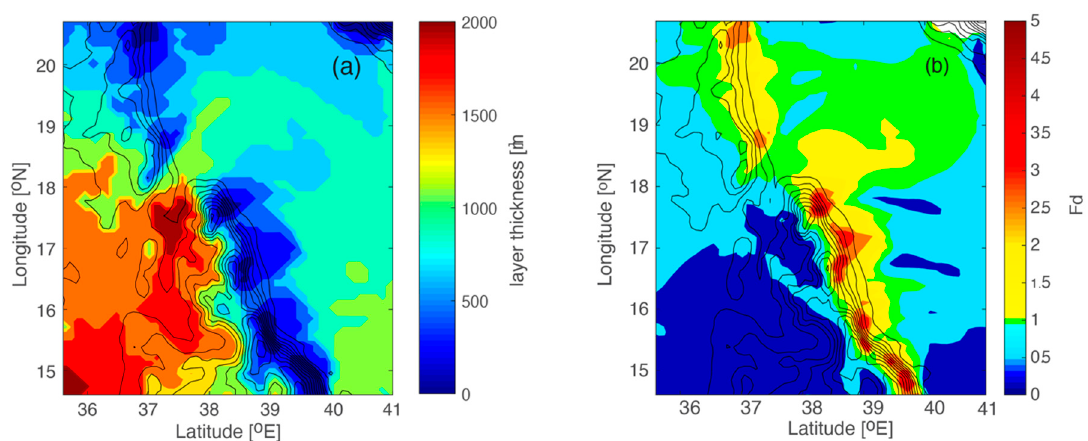
Figure 10. ( a ) Thickness of the layer formed between the ground level and the 312 K surface; ( b ) the local Froude number F d based on the 1.5-layer model with a interface at 312 K. Both plots for 05 UTC on 12 July 2008.